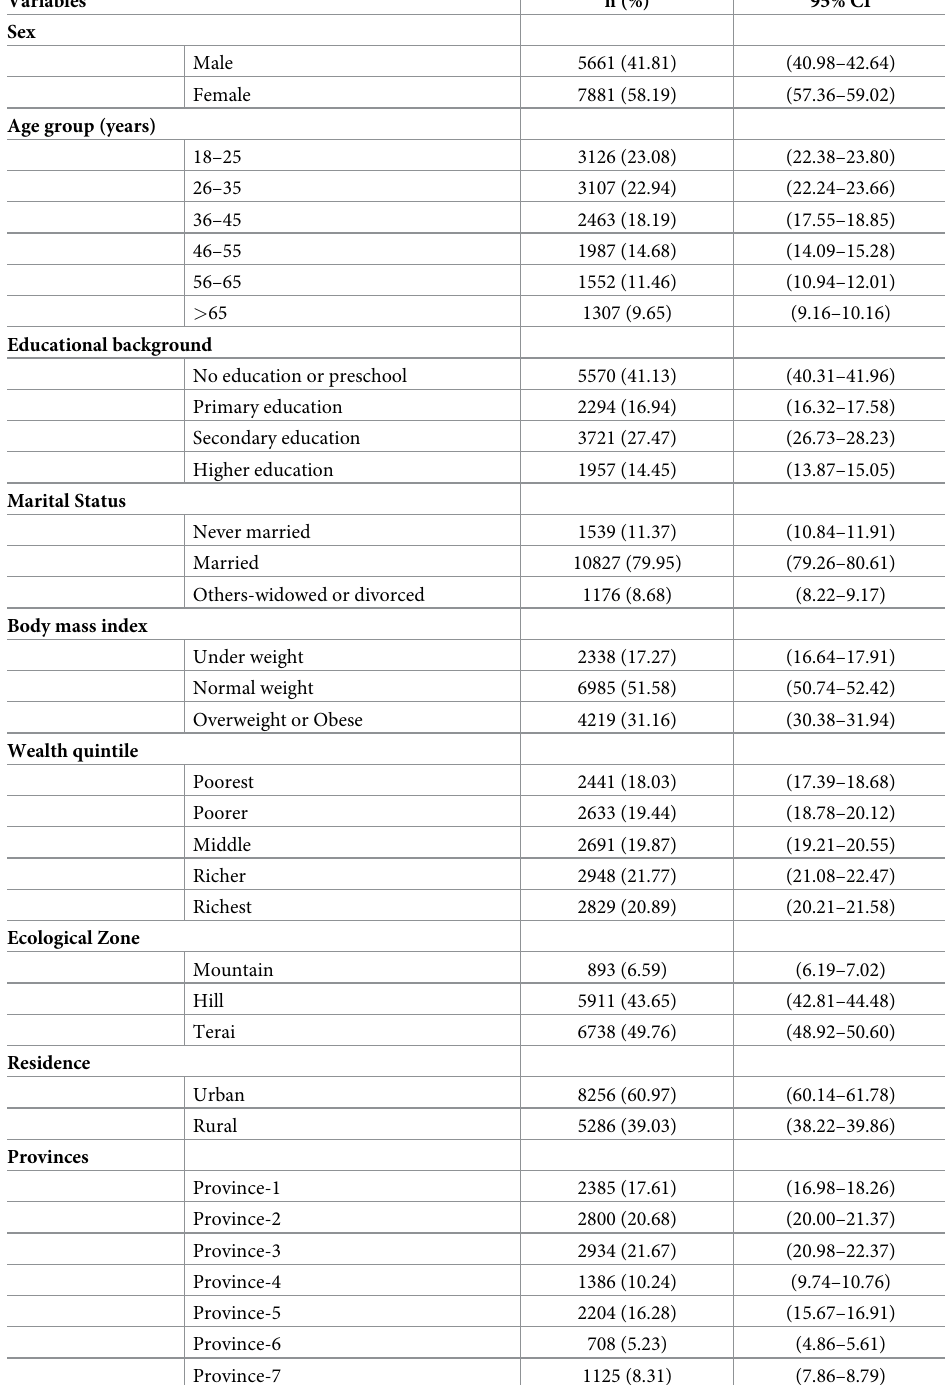
Table 1. Background characteristics of study